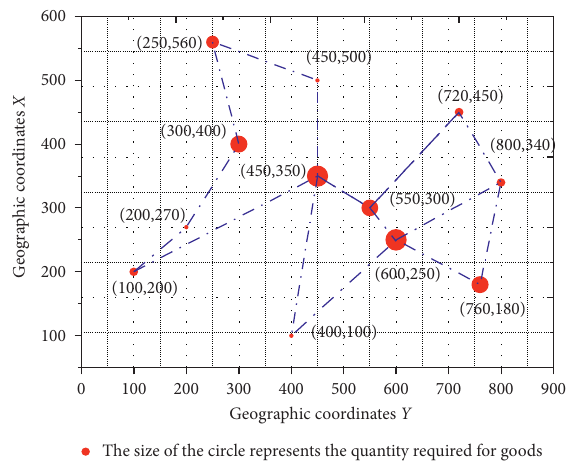
Figure 7: Distribution route and demand for goods at each distribution